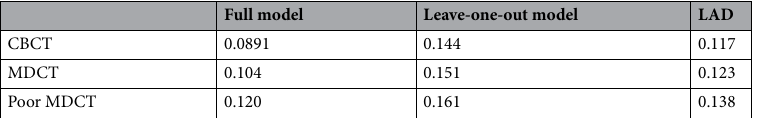
Table 2. Average vertex errors (mm) for the 17 specimens without an implanted electrode, at a grayscale threshold of 170. The tabulated numbers are the average distances between vertices on the fitted model and the gold-standard mesh, after optimal rigid body alignment of the two